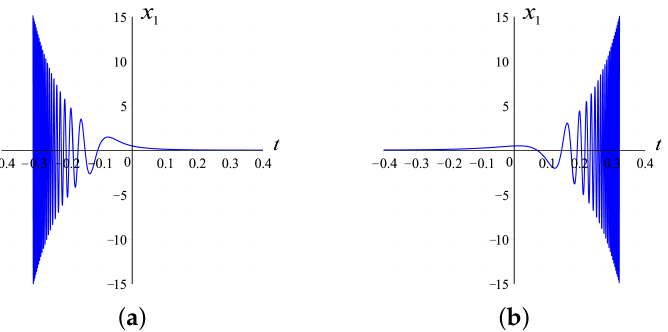
Figure 4. Time series graphs of x 1 direction: ( a ) Stable region; ( b ) Unstable